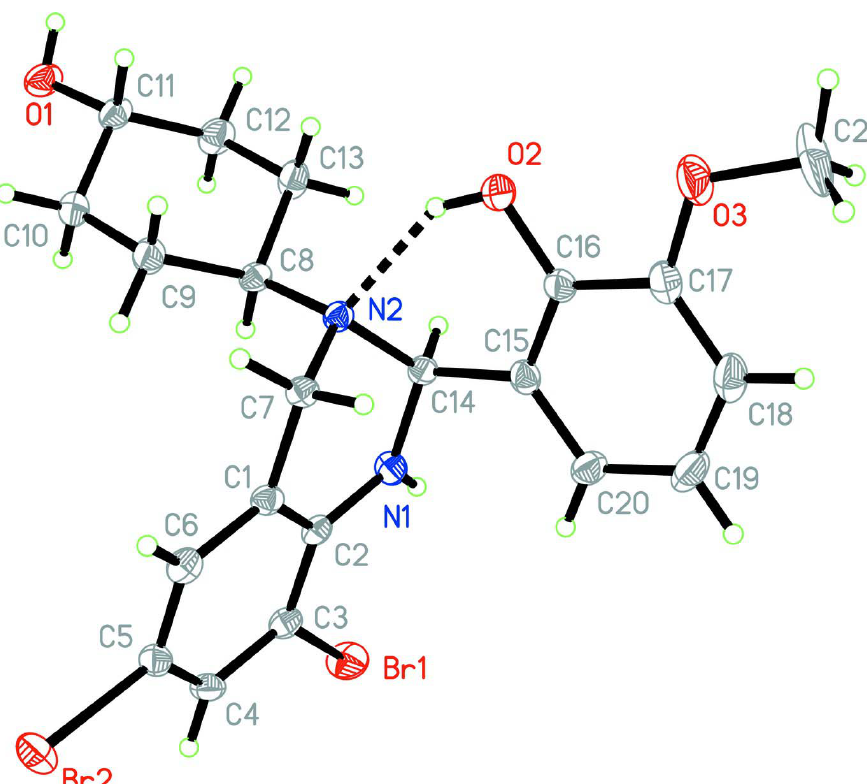
Figure 1 The structure of (I) at the 30% probability level. The intramolecular O–H···N hydrogen bond is shown as a dashed